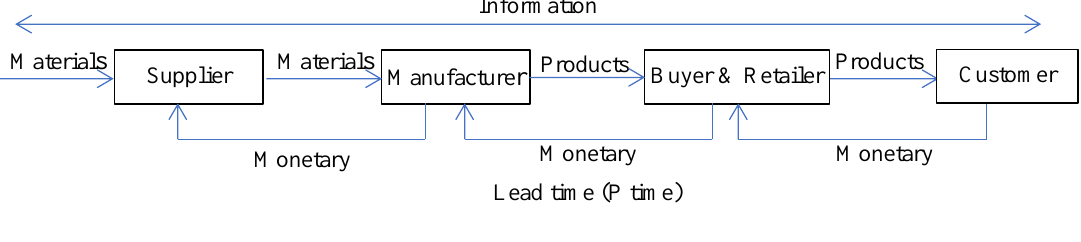
Figure 2. Supply chain structure of the current case